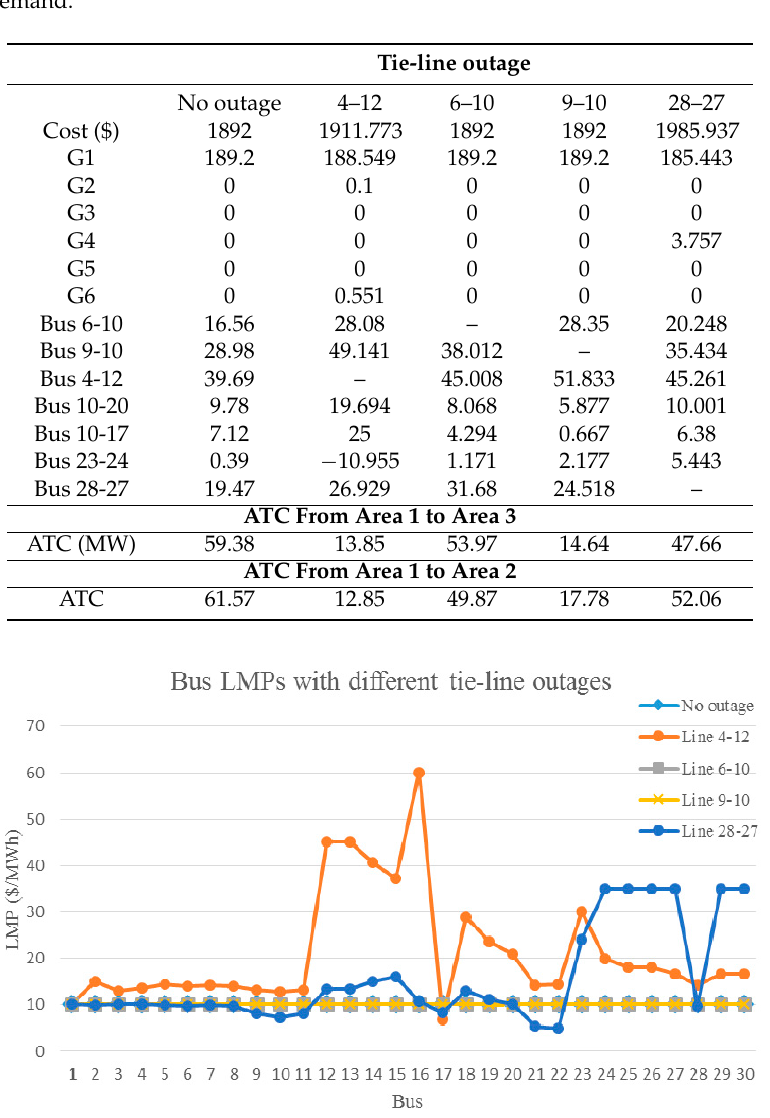
Table 6. ATC and ED results of IEEE 30 ‐ bus system under different tie ‐ line outages with 189.2 MW demand. Tie ‐ line outage ATC and ED results of IEEE 30-bus system under different tie-line outages with 189.2 MW demand.